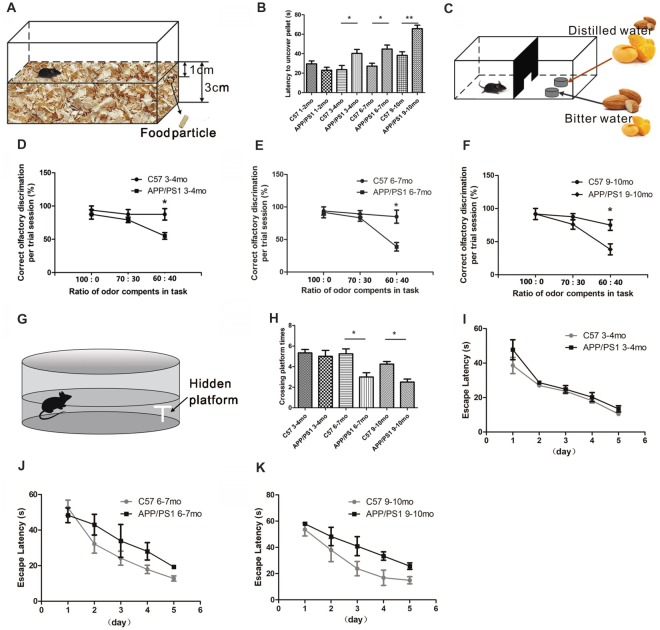
Atypical olfactory and cognitive behaviors of amyloid precursor protein (APP)/PS1 mice. (A) Design of the buried food test. (B) Quantitative statistical analysis of latency of 3–4-, 6–7 and 9–10-month-old (mo) APP/PS1 and C57 mice to find the hidden food particle. (C) Design of the fine odor discrimination test. Mice were deprived of water for 24 h and trained to identify distilled water. In one dish, the distilled water was coupled with an odor mixture of mango and almond, in which mango was the main component. The other dish contained bitter water with an odor mixture in which almond was the main component. Different odor proportions of mango and almond were used in the performance test. (D–F) Performance of APP/PS1 and C57 mice at 3–4 (D), 6–7 (E), and 9–10 months of age (F). (G) Design of the Morris water maze (MWM) test. (H) Quantitative statistics of the crossing platform times of APP/PS1 and C57 mice at 3–4, 6–7 and 9–10 months of age. (I–K) Escape latencies of APP/PS1 and C57 mice at 3–4 (I), 6–7 (J) and 9–10 months of age (K). The data are presented as the means ± standard errors of the means (SEMs). *p < 0.05; **p < 0.01.